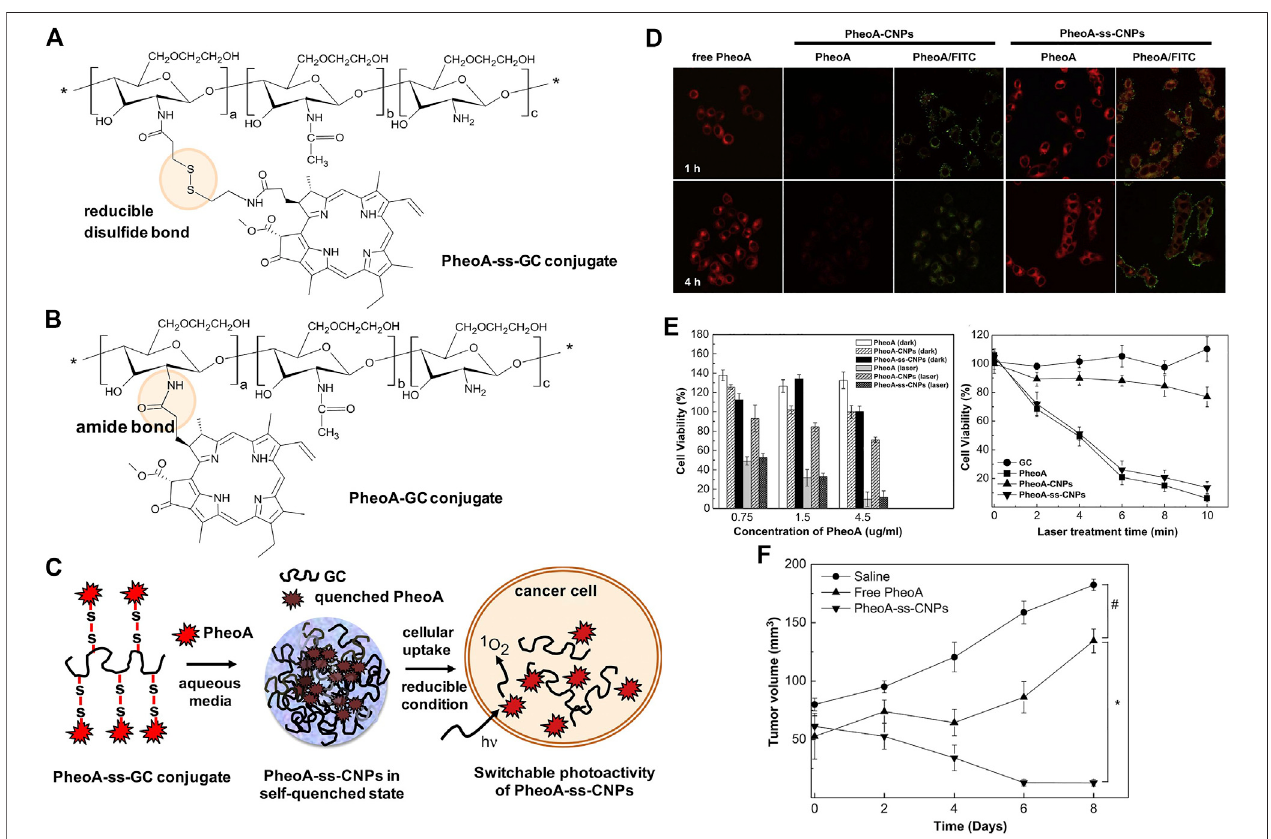
FIGURE 8 | Chemical structures of (A) PheoA-ss-GC and (B) PheoAeGC conjugates and (C) illustration of bioreducible PheoA-ss-CNPs for switchable photoactivity of PheoA; (D) CLMS images of KB cells treated with free PheoA, PheoAeCNPs, and PheoA-ss-CNPs; (E) phototoxicity and dark toxicity of free PheoA, PheoAeCNPs, and PheoA-ss-CNPs; (F) tumor growth of HT-29 tumor-bearing mice after various treatments. Reprinted with permission from Oh et al. (2013).